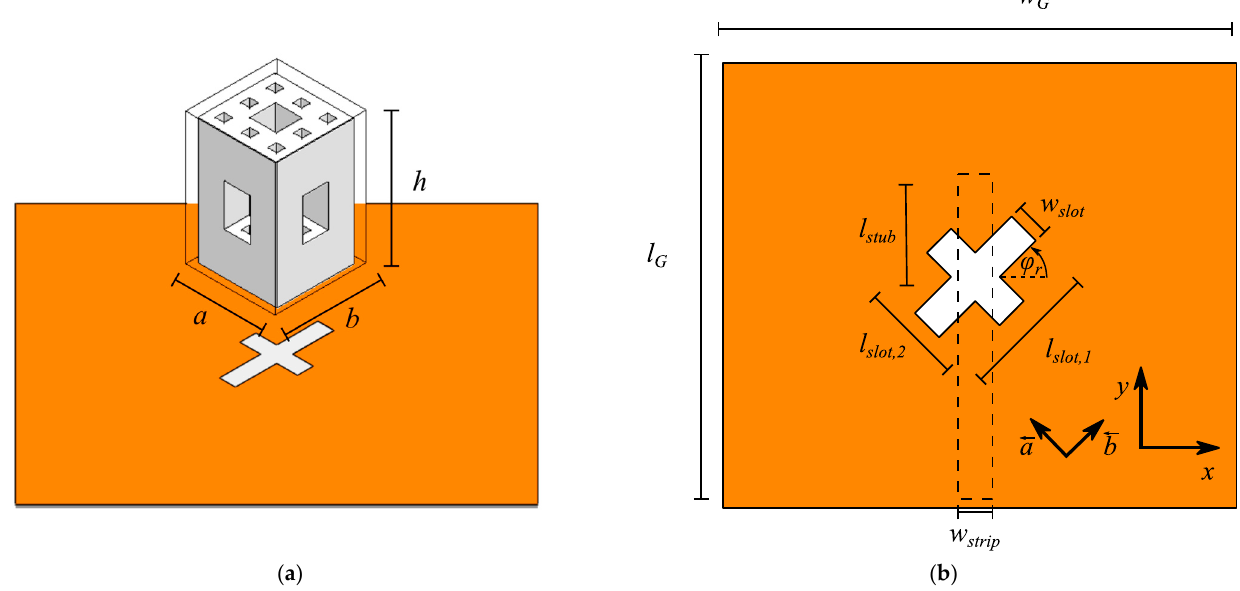
Figure 10. ( a ) Perspective view of the menger sponge fractal from Figure 8, showing its dimensions, along with the feeding mechanism. ( b ) Top view of the feeding PCB with a cross slot with lengths l slot,1 , l slot,2 , and width w slot . The slot is accommodated by a microstrip feed line with a width w strip and extends the center of the cross slot by a length l stub . The ground plane has a length and width of l G and w G , respectively. The feeding substrate has a thickness of t sub . The feeding slot is rotated by an angle of ϕ r